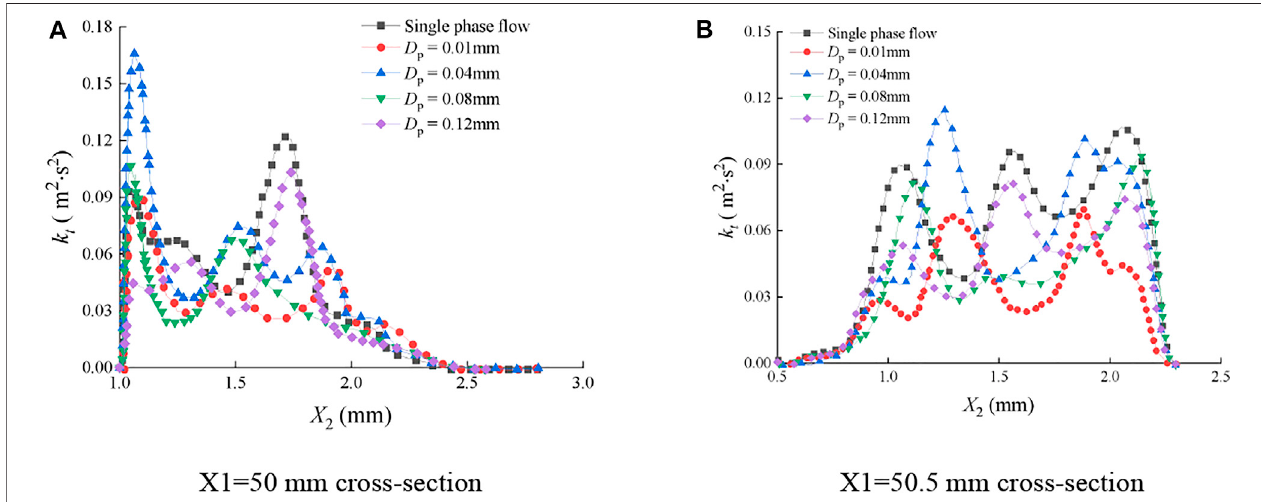
FIGURE 17 | Distribution of turbulent kinetic energy of the continuous-phase fl uid on cross sections of the rough fracture. (A) X1=50 mm cross section; (B) X1=50.5 mm cross section.